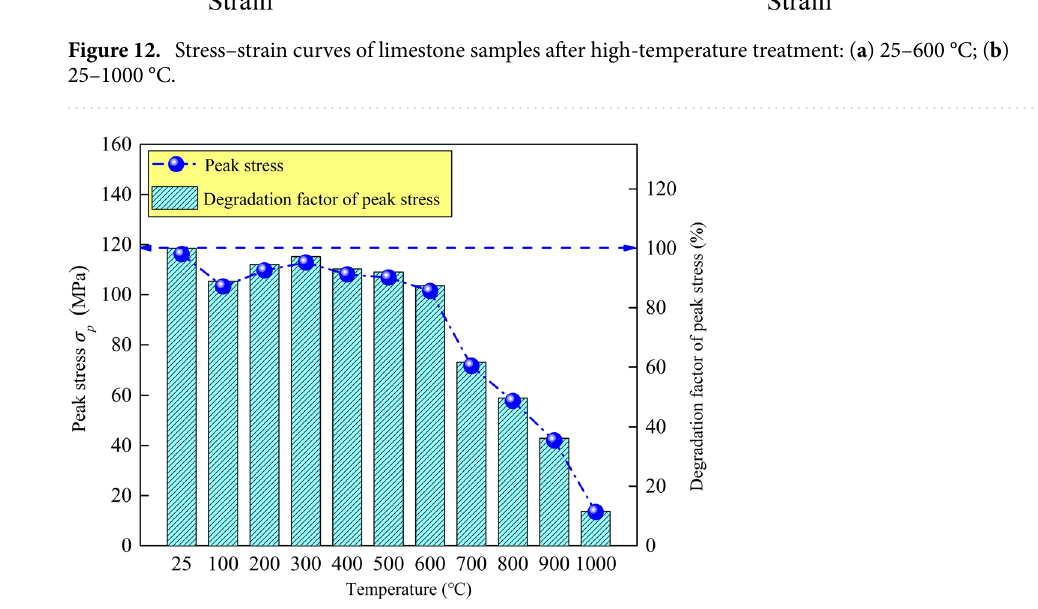
Figure 13. Variation of the peak stress and peak stress degradation factor of limestone samples with